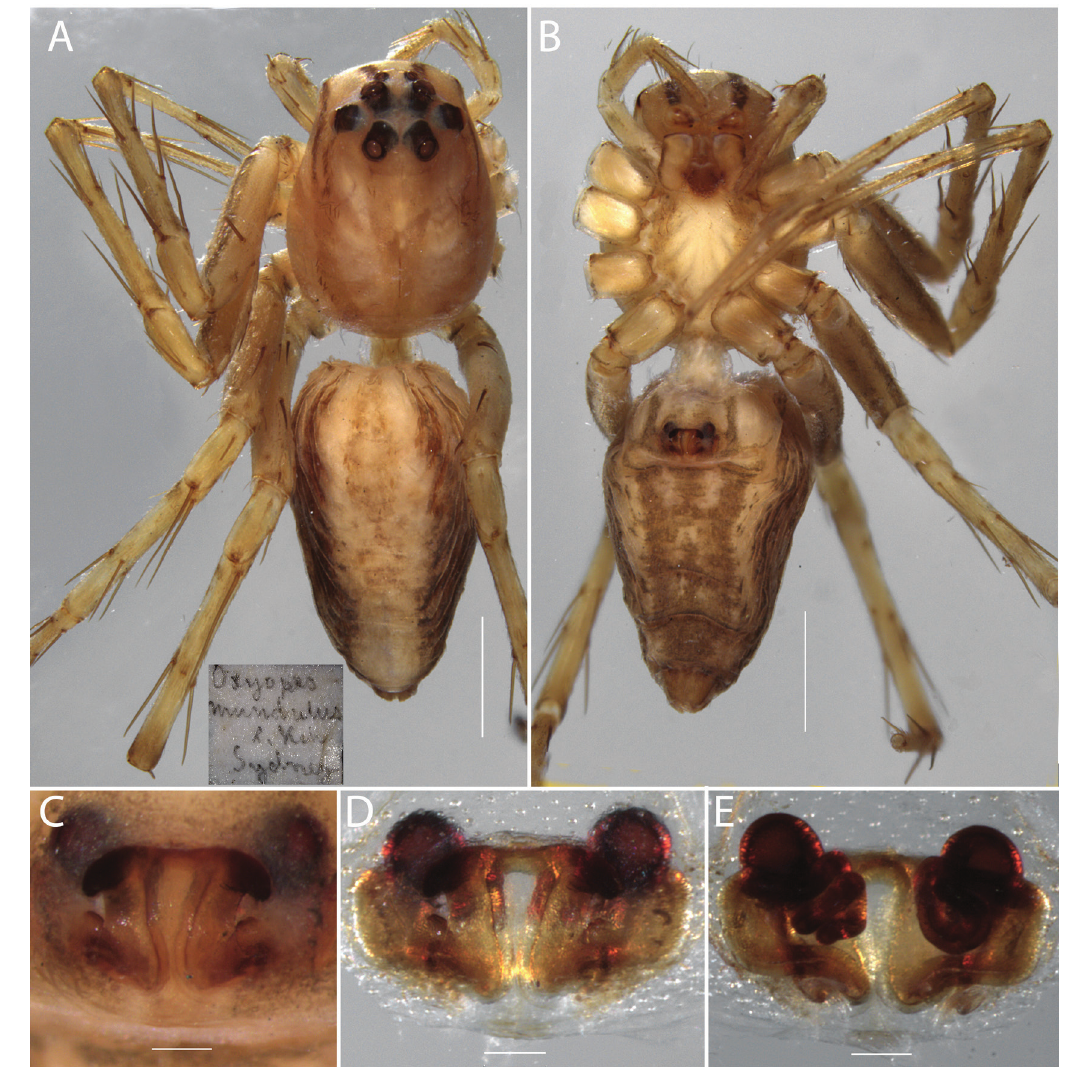
Figure 12. Oxyopes mundulus L. Koch, 1878, female syntype ( ZMH- A0000015): A , habitus, dorsal view; B , habitus, ventral view; C , epigyne, ventral view; D, epigyne, ventral view, cleared; E , epigyne, dorsal view, cleared. Scale bars: habitus 1.0 mm, epigyne 0.1 mm